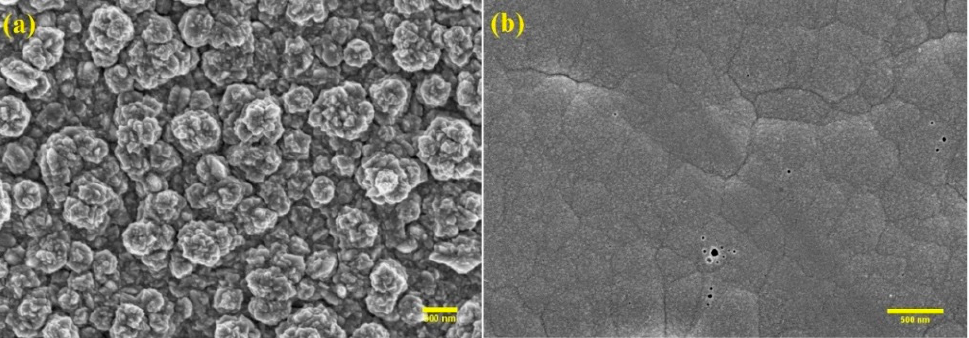
Figure 2. SEM images of surface morphologies of electrodeposited ( a ) NiW chloride and ( b ) NiW sulfate coatings.